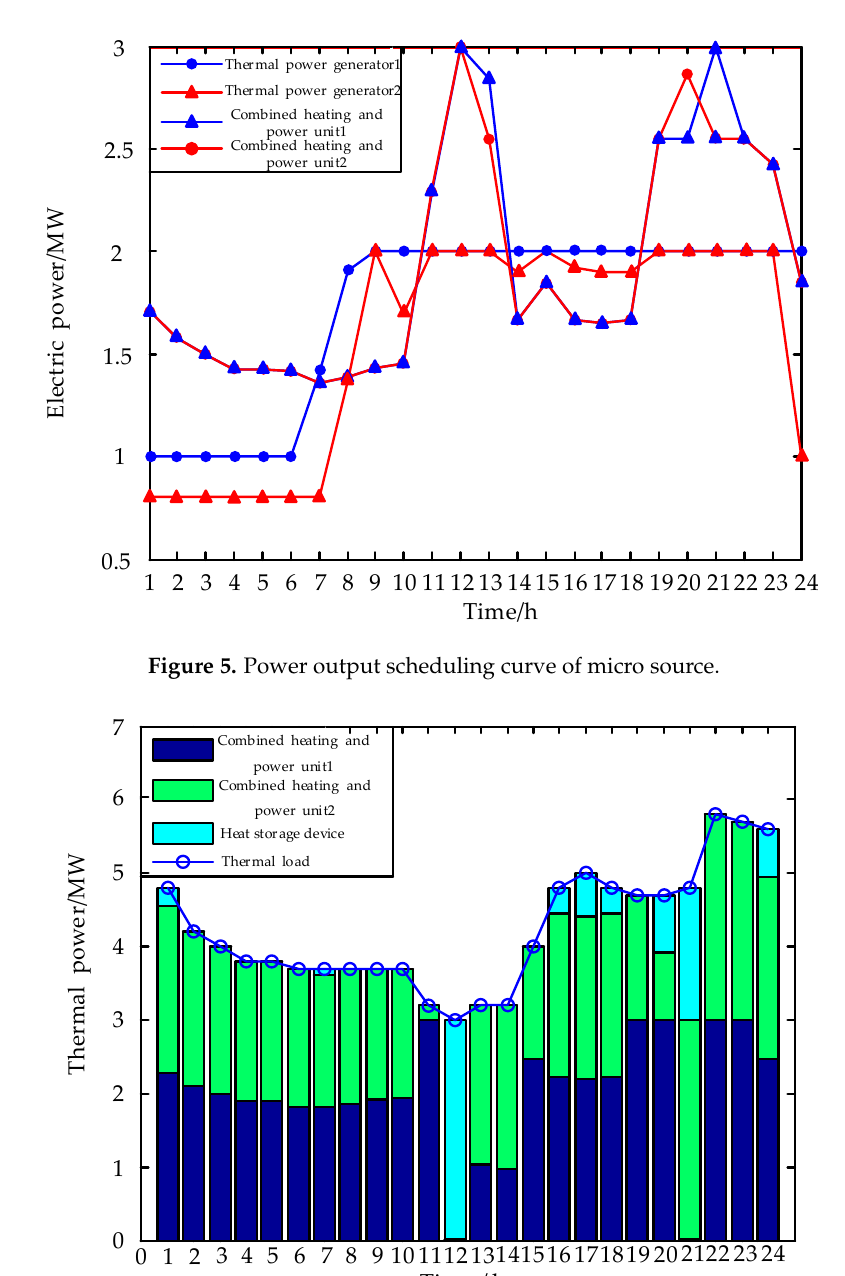
Figure 6. Heat power scheduling curve of combined heat and power unit.